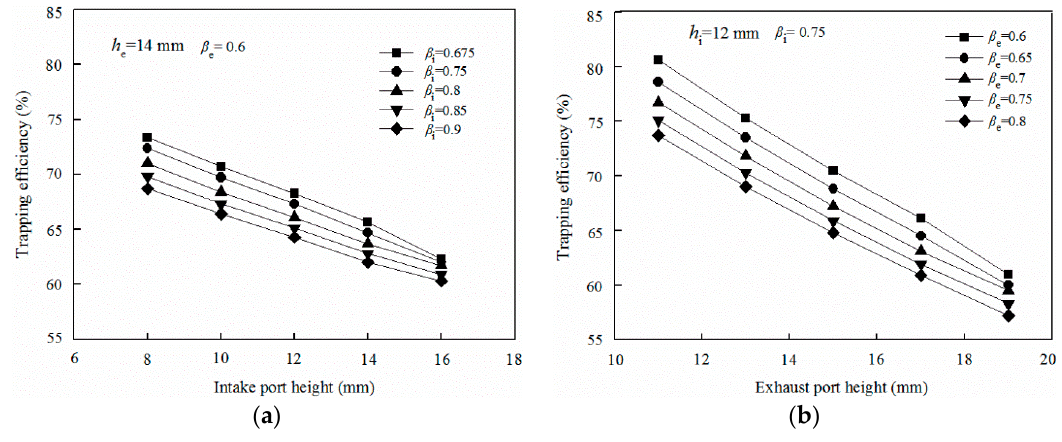
Figure 10. Effect of the port height and circumference ratio on trapping efficiency ( a ) Intake port; ( b ) Exhaust port.